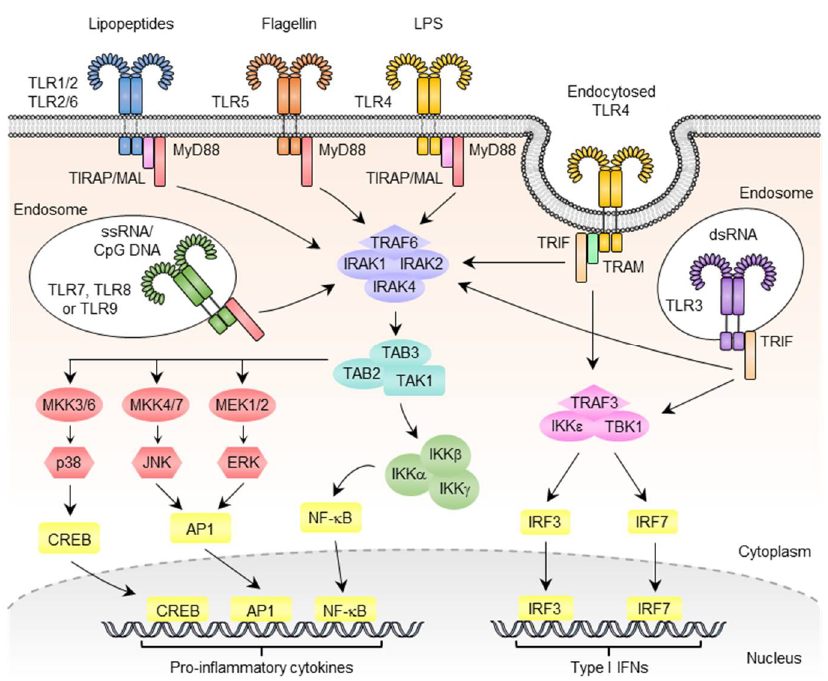
Figure 2. Overview of TLR signaling pathways. TLRs localize to the cell surface and in endosome compartments, where they detect pathogens from microbes. Upon stimulation, TLRs activate two major downstream adaptor proteins, MyD88 and TRIF. Engagement of the signaling adaptor molecules stimulates downstream signaling cascades that involve the production of proinflammatory cytokines and interferons (IFNs). PAMP, pathogen-associated molecular pattern; DAMP, damage-associated molecular pattern; LPS, lipopolysaccharide; MyD88, myeloid differentiation primary response 88; MAL, MyD88 adaptor-like protein; TRIF, TIR domain-containing adaptor-inducing interferon-β; TRAM, TRIF-related adaptor molecule; TRAF, tumor necrosis factor receptor-associated factor; IRAK, interleukin-1 receptor-associated kinase; TBK1, TANK-binding kinase 1; TAB, TAK1-binding protein; TAK1, TGF-β-activated kinase 1; IKK, inhibitor of NF-κB kinase; NF-κB, nuclear factor kappa-light-chain-enhancer of activated B cells; ERK, extracellular signal-regulated kinase; JNK, c-Jun N-terminal kinase; AP-1, activator protein 1; CREB, cAMP-responsive element-binding protein; IFN, interferon; IRF, IFN regulatory factor.